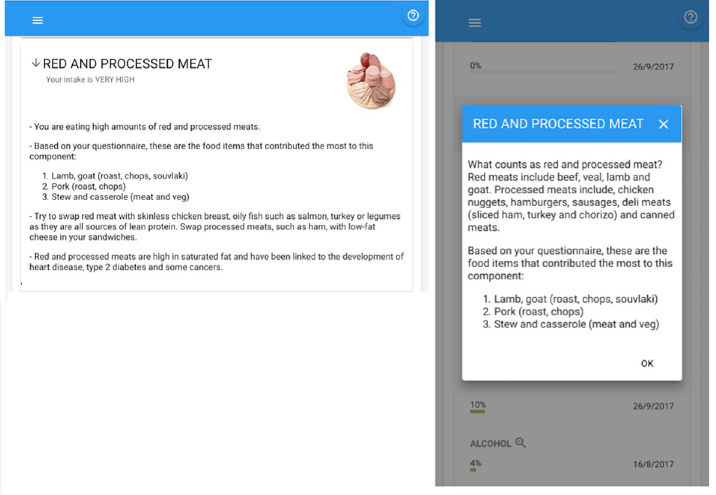
Fig 3. Advice on the biggest contributors to a component as main advice and component details. Reprinted from [10] under a CC BY license, with permission from Rodrigo Zenun Franco, 2019.